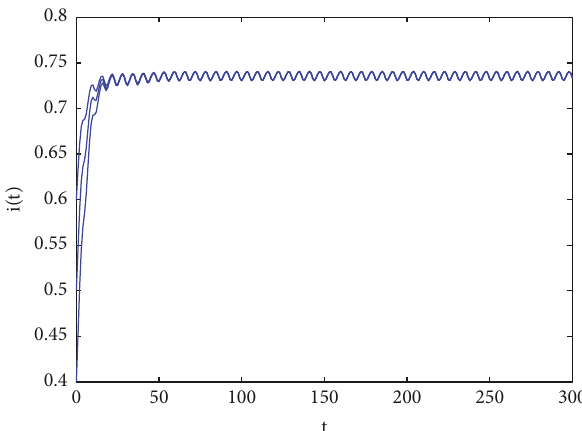
Figure 1: Numerical solutions 𝑖(𝑡) of model (35) for initial value 𝜑(𝑡) = 0.4,0.5,0.6, 𝑡 ∈ [−50,0]